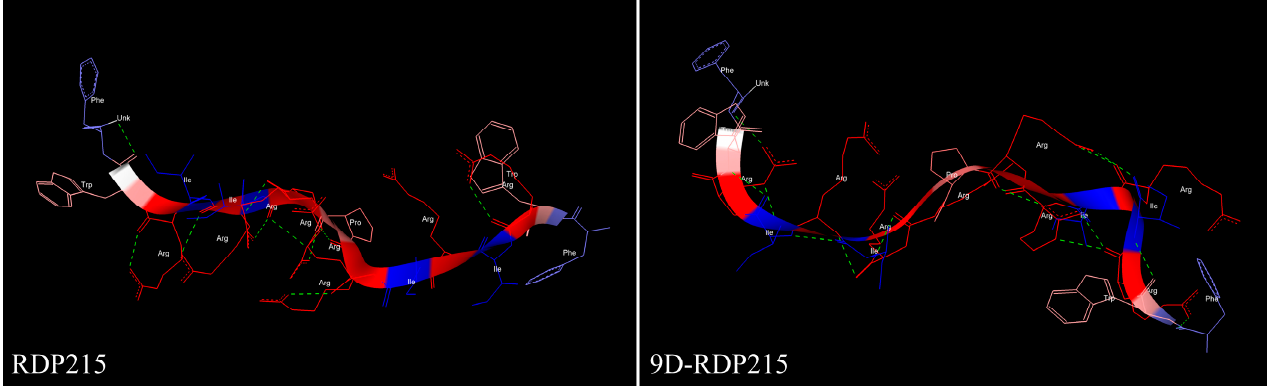
Figure 2. In silico structure prediction of RDP215 (left ) and 9D-RDP215 ( right ) with PEPstrMOD. The PEPstrMOD structure prediction revealed a rather extended structure with similar distribution of amino acid residues for the peptides RDP215 and 9D-RDP215.